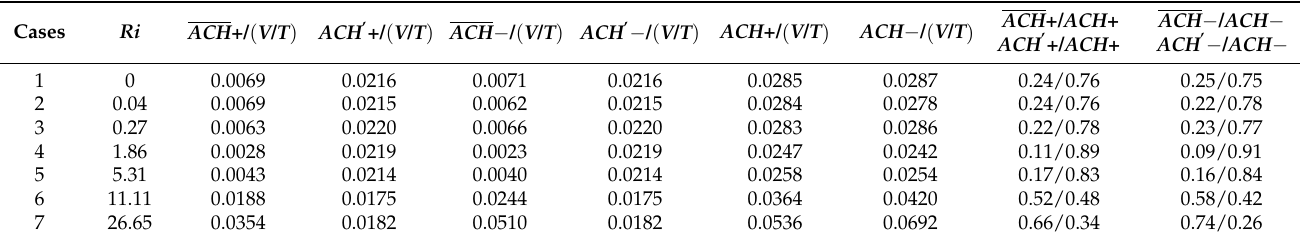
Table 4. Dimensionless air exchange rate ( ACH +/ − ) for single-sided ventilation under different Ri